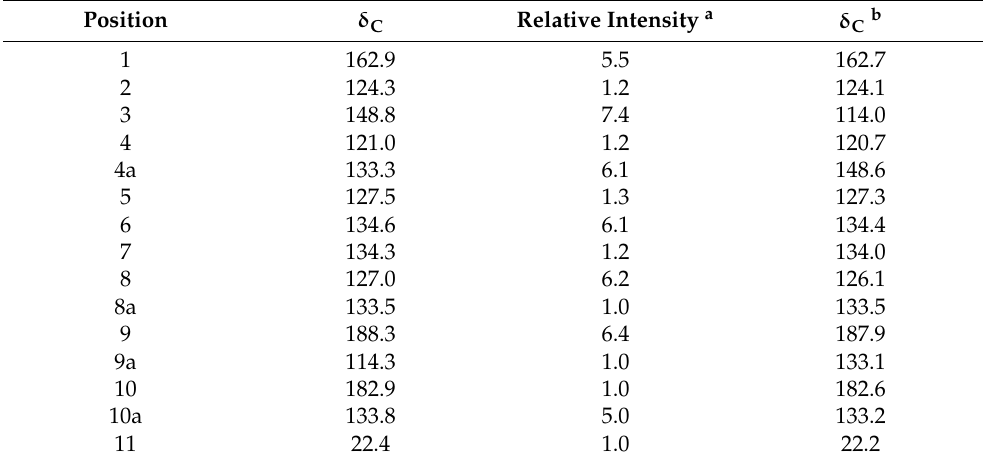
Table 3. Assignment of 13 C-NMR resonances using labelled pachybasin ( 5 ) in comparison to literature.